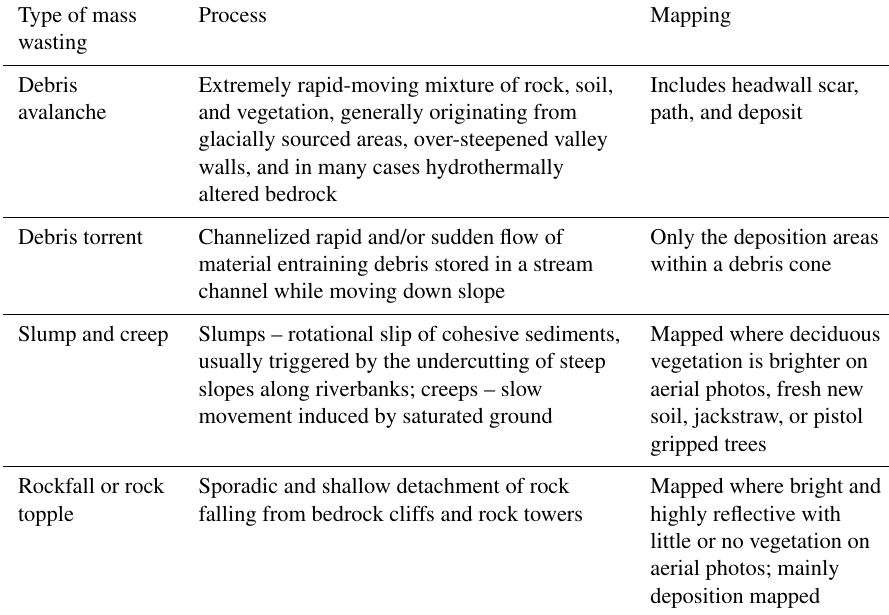
Table 2. Landslides mapped as part of a comprehensive landform mapping study used in hazard analysis (Riedel et al., 2012). Type of mass Process Mapping wasting Debris Extremely rapid-moving mixture of rock, soil, Includes headwall scar, avalanche and vegetation, generally originating from path, and deposit glacially sourced areas, over-steepened valley walls, and in many cases hydrothermally altered bedrock Debris torrent Channelized rapid and/or sudden flow of Only the deposition areas material entraining debris stored in a stream within a debris cone channel while moving down slope Slump and creep Slumps – rotational slip of cohesive sediments, Mapped where deciduous usually triggered by the undercutting of steep vegetation is brighter on slopes along riverbanks; creeps – slow aerial photos, fresh new movement induced by saturated ground soil, jackstraw, or pistol gripped trees Rockfall or rock Sporadic and shallow detachment of rock Mapped where bright and topple falling from bedrock cliffs and rock towers highly reflective with little or no vegetation on aerial photos; mainly deposition